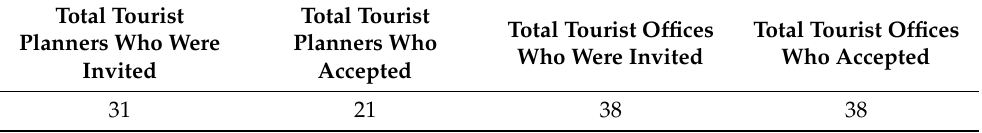
Table 2. Tourist planners and tourist offices in Spain who took part in the selection of variables.